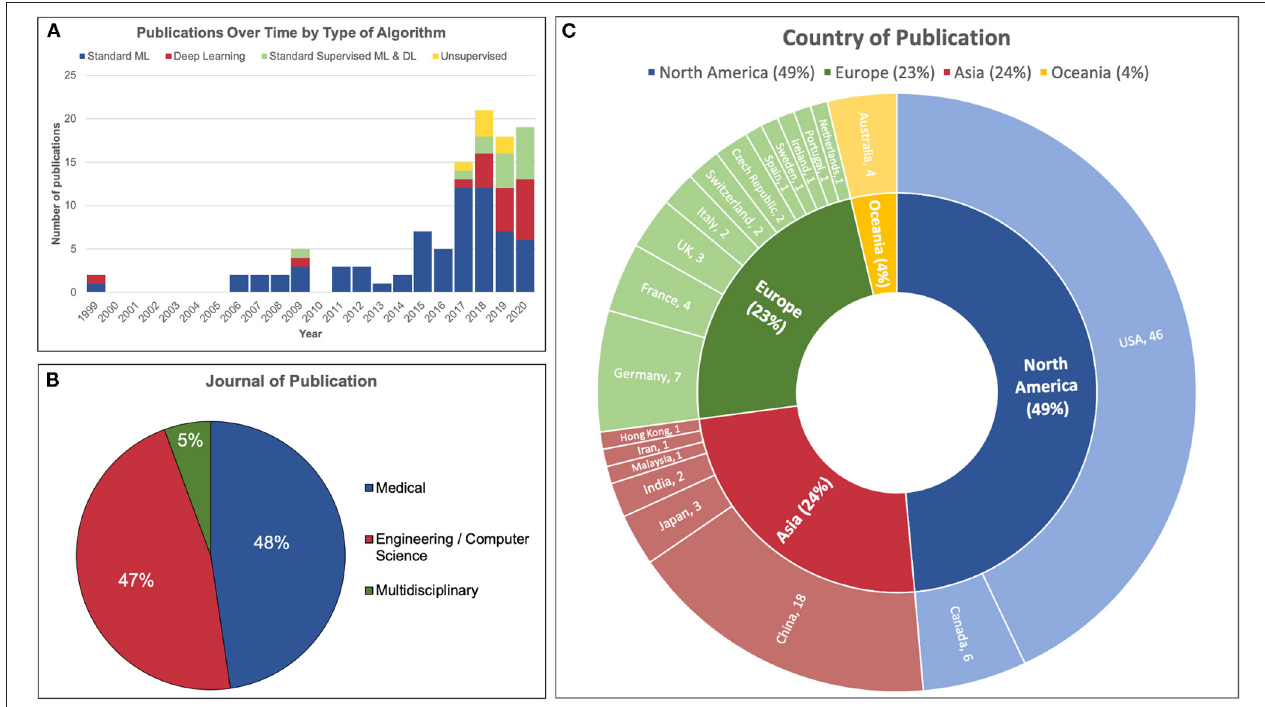
FIGURE 3 | Demographics of 107 articles reviewed. (A) The number of publications in the field of machine learning and iEEG dramatically increased in 2017 incorporating more deep learning and unsupervised learning models. (B) Just under half of articles reviewed were published in a medical journal and a similar proportion were published in an engineering or computer science journal. A minority was published in a multidisciplinary journal. (C) Almost half of the studies were conducted in North America. The United States published the most papers, followed by China, Germany and